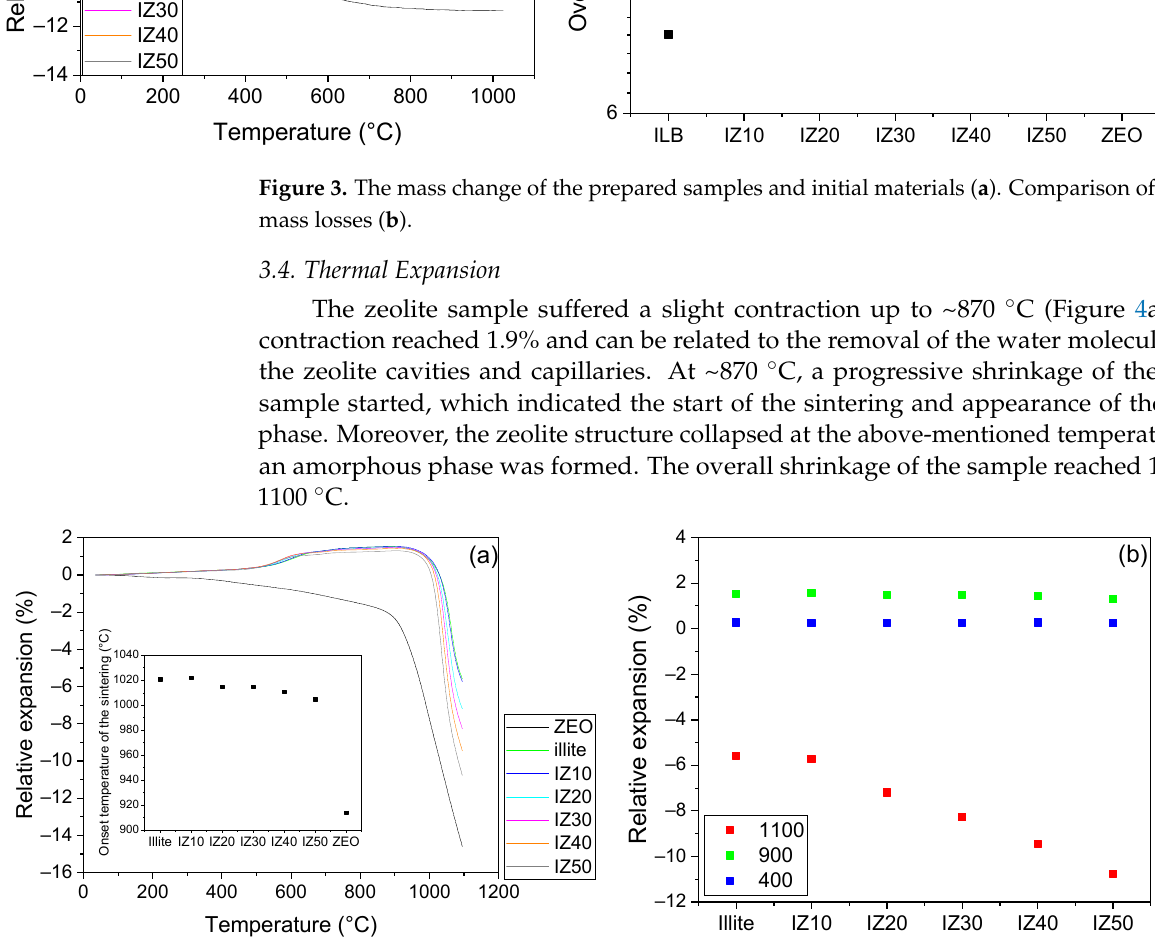
Figure 4. Dilatometry of the prepared mixtures and initial materials. Inset graph: Onset of the sintering ( a ). Relative expansion of the samples at different temperatures ( b ).